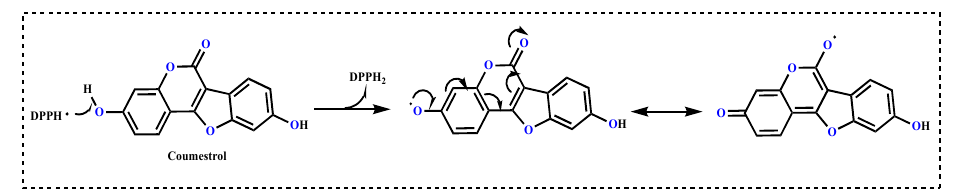
Figure 6. Purposed DPPH radical ‐ scavenging mechanism between Coumestrol and DPPH radicals.